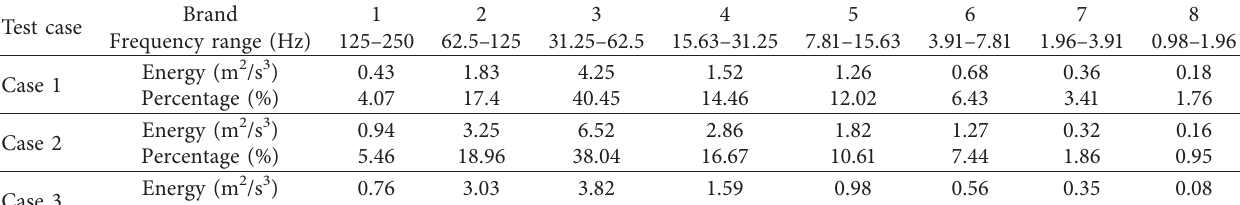
Table 4: Energy of the trailer bogie frame at each decomposition level and its percentage of the total energy in respect of different cases. Test case